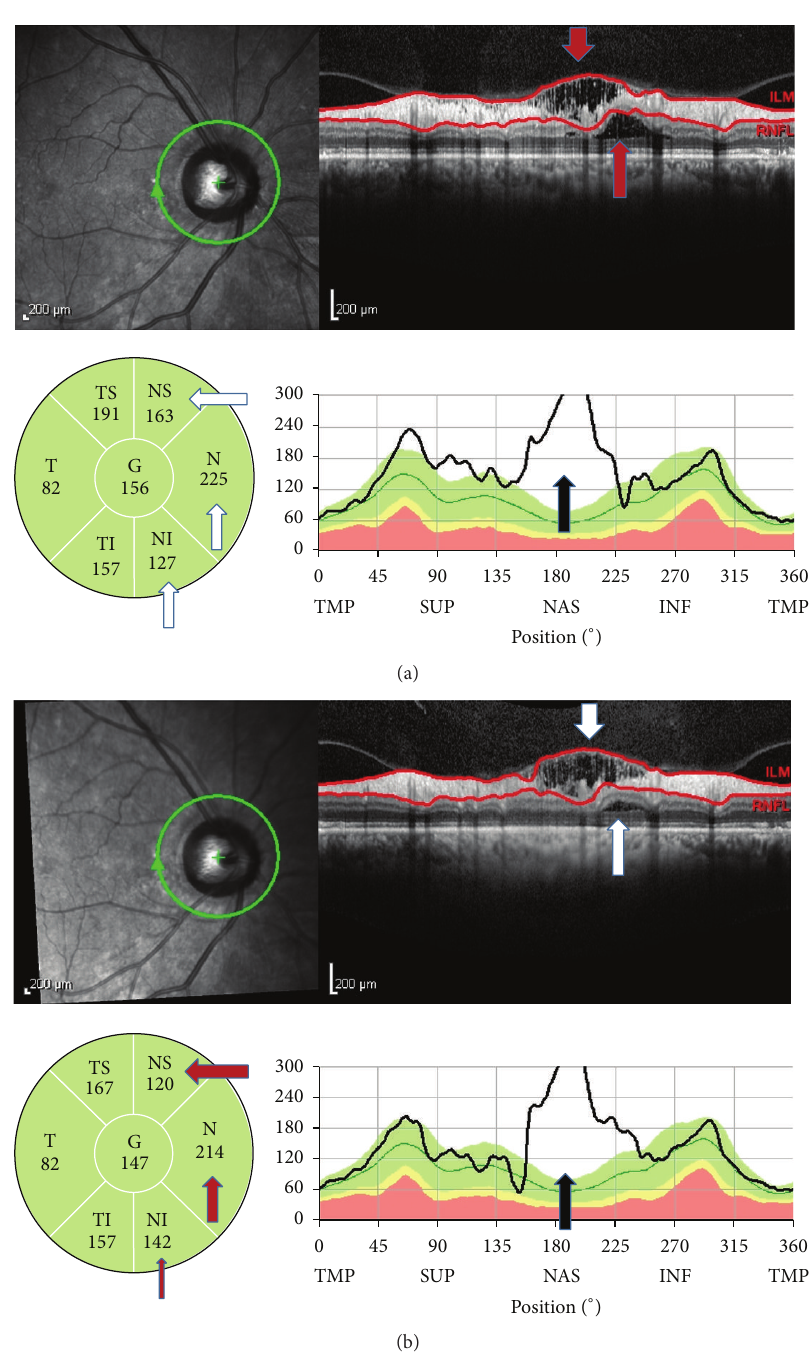
Figure2:SD-OCTfindingsinacaseofglaucoma-suspect.ShehadalargediscwithcuppingbutIOPwasunder15 mmHg.(a)Theretinoschisis observed in the B-scan image (red arrows), in the sector thickness map (white arrows), and in the TSNIT graphs (black arrow). (b) The extension of retinoschisis was smaller 3 months later in B-scan image (white arrows), in the sector thickness map (red arrows), and in the TSNIT graphs (black